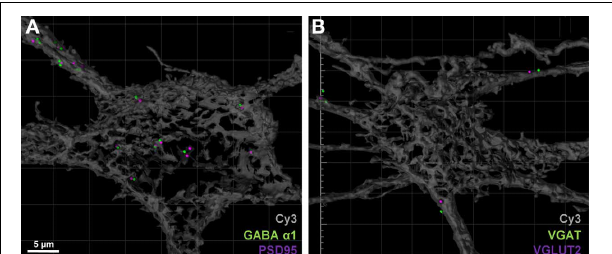
FIGURE 6 | Excitatory and inhibitory immuno-labels do not substantially overlap when localized to motor neurons. (A) shows the co-localization (within 1 μ m) of post-synaptic excitatory PSD-95 (purple) and inhibitory GABA-A receptor subunit α 1 (green) on a Neurobiotin = filled hypoglossal motor neuron (gray). Only 15% of all PSD-95 spots are co-localized with a GABA-A receptor subunit α 1 puncta. (B) shows the co-localization (within 1 μ m) of pre-synaptic excitatory VGLUT2 (purple) and inhibitory VGAT (green) within 1 μ m from the surface of a Neurobiotin = filled hypoglossal motor neuron (gray). Note that less than 10% of all VGLUT2 terminal boutons are co-localized with VGAT terminals. Scale bar: 5 μ m.